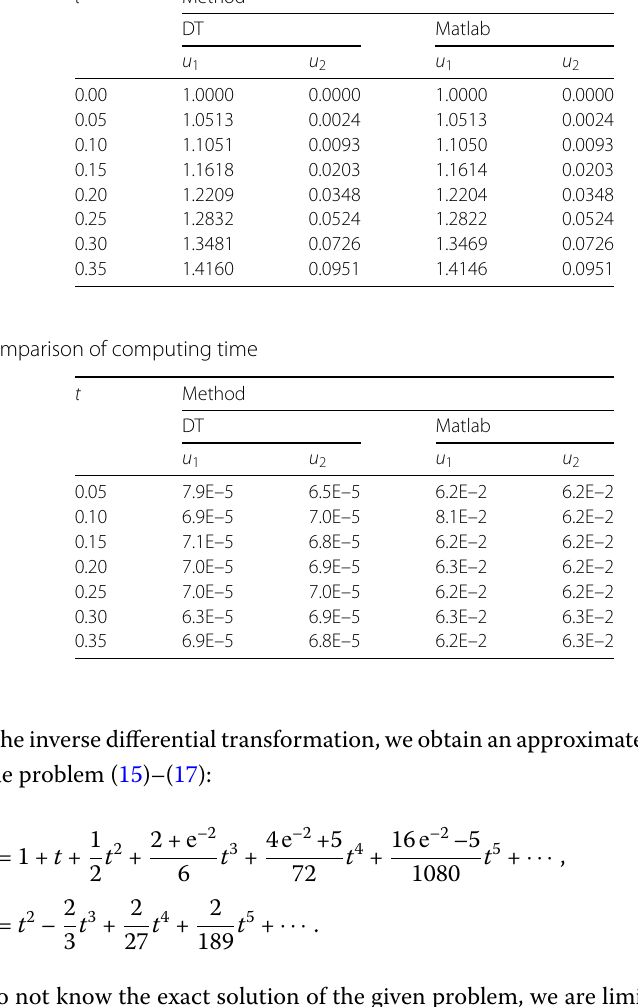
Table 7 Comparison of values of solution components obtained by DT and Matlab t Method DT Matlab